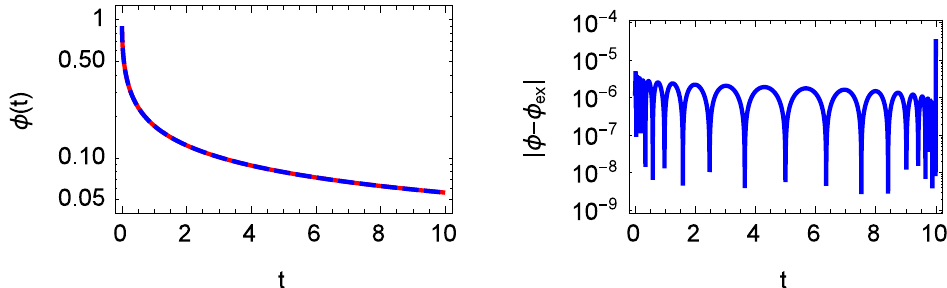
Figure 2. Approximations of the fractional relaxation Equation (84) using the fractional order (cid:12) = 1 = 2 . The initial condition and the relaxation time (cid:28) (cid:28) = 1 = 10 . The solid line represents the analytic solution E 0 of the Riemann-Liouville representation used N = 32 Sinc